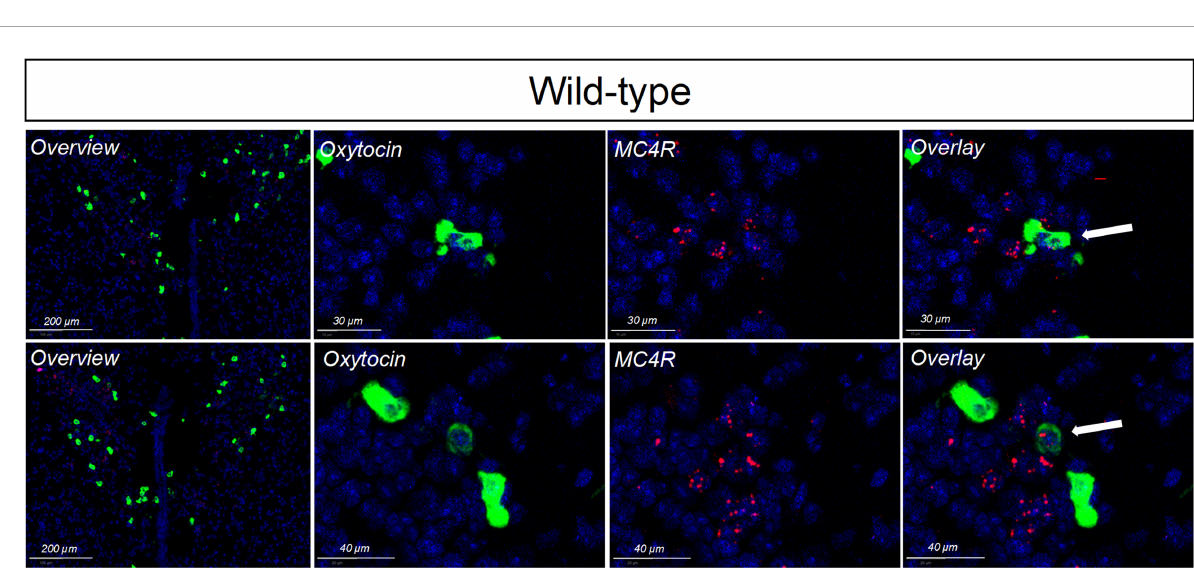
FIGURE 4 In situ hybridization for oxytocin (labeled in red) and MC4R (labeled in green) in the PVH of wildtype mice. Nuclei were labelled using DAPI (blue). Limited, but detectable, overlap was